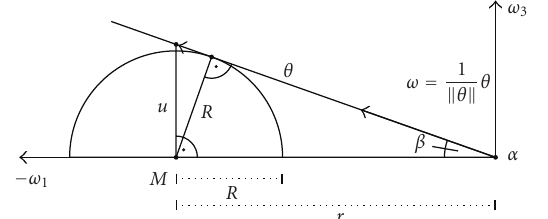
Figure 13: Clarifying the calculation of the maximal value for ω 3 .